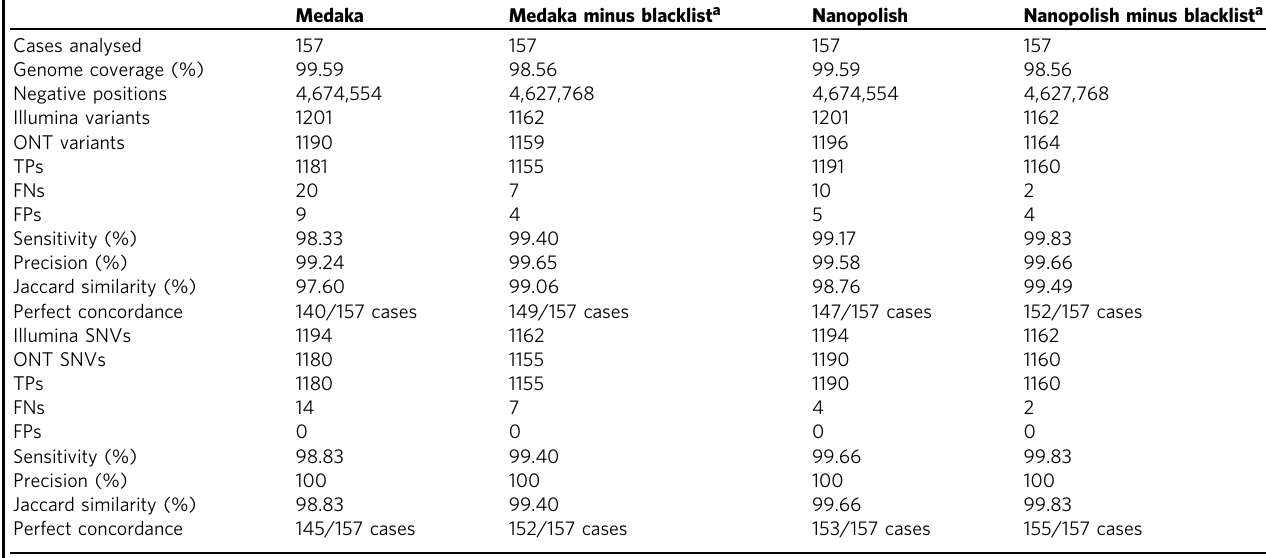
Table 2 Consensus-level accuracy of ONT whole-genome SARS-CoV-2 sequencing on patient specimens. Medaka Medaka minus blacklist a Nanopolish Nanopolish minus blacklist a Cases